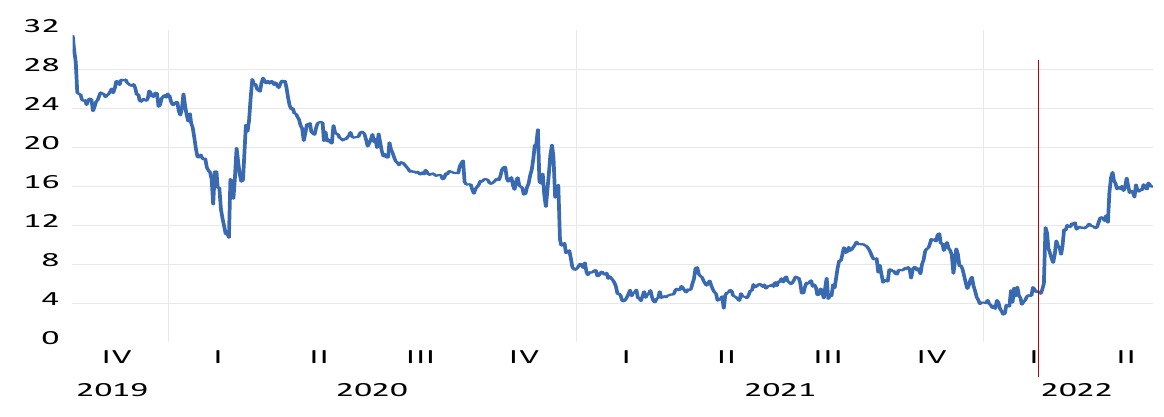
Figure 4. Total volatility spillover index percent.